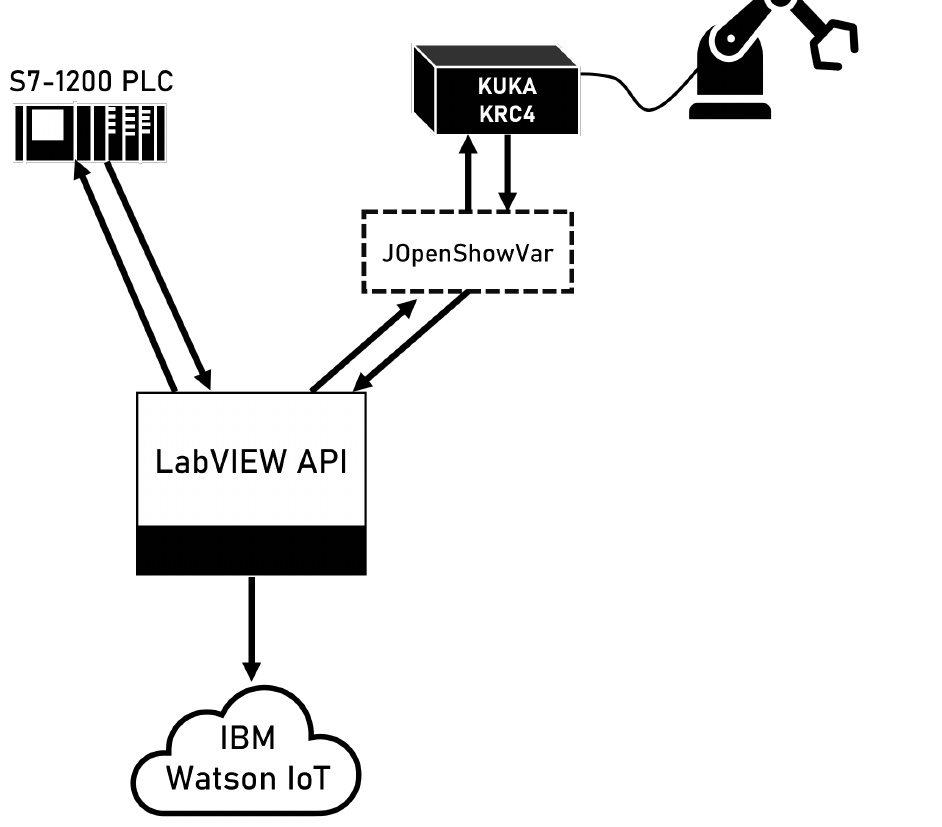
Figure 10. Interfacing